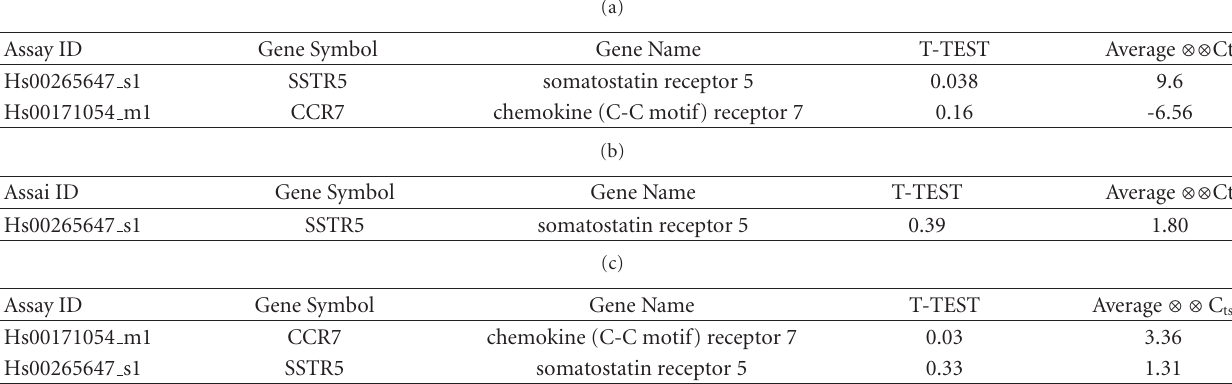
Table 1: Di ff erential gene expression in (a) PBMCs of healthy donors and CD patients, (b) PBMCs of healthy donors and CD patients after LPS stimulation and (c) biopsies experiments. Results from each card were quantified in a relative comparative study, using an automatic baseline and threshold to record the cycle thresholds (C ts ) setting and the 18S rRNA gene expression as a reference for normalization ( Δ C ts ). Identification of genes di ff erentially expressed in Crohn’s patients versus control group was performed ( ΔΔ C ts ) using standard statistical analysis methods as the Student’s t -test with the commonly accepted significance threshold of P < . 05.